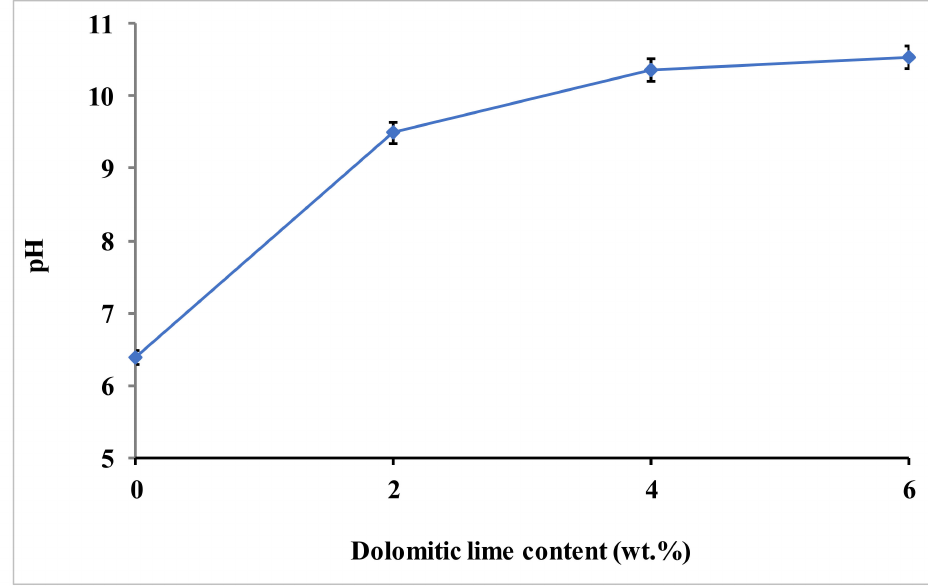
Figure 8. Variation of pH versus dolomitic